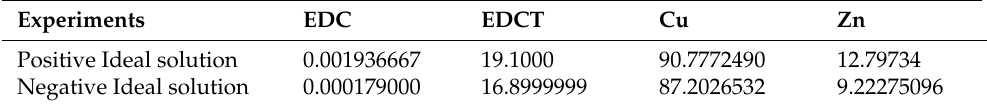
Table 13. Positive and negative ideal solutions.